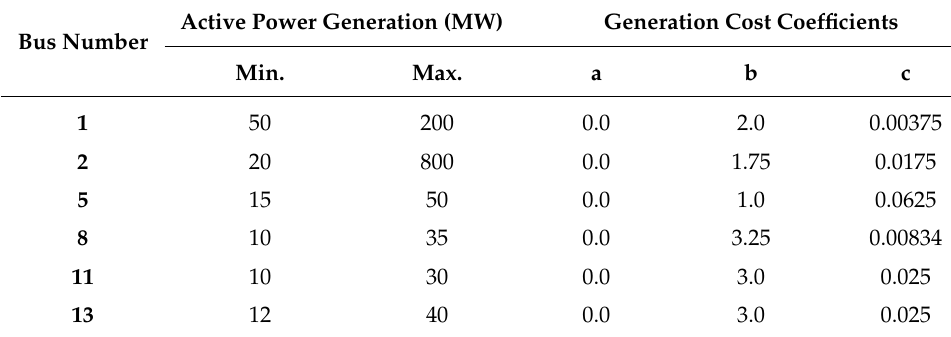
Table 2. Generator data of the IEEE-30 bus test system [39].